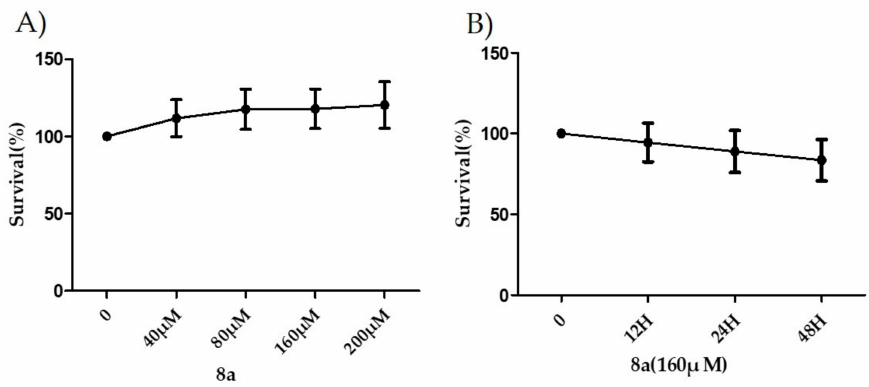
Figure 2. The inhibitory rates of 8a on cell proliferation at di ff erent concentrations and time durations on LX-2 cells by sulforhodamine B (SRB) assay.